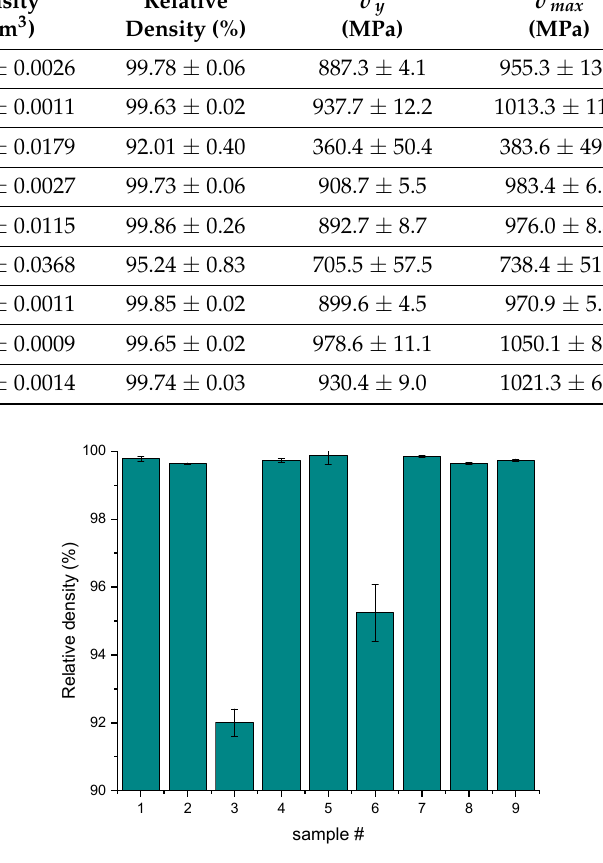
Table 4. Density, relative density, yield strength, ultimate tensile strength, elongation at break, and hardness values.